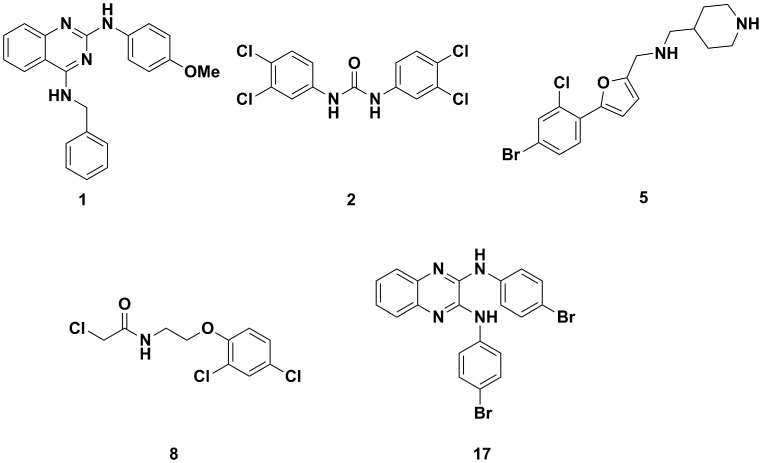
Chemical structures of the five lead compounds selected for in vivo studies.